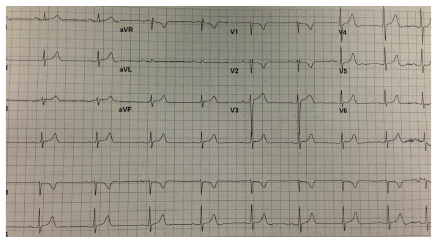
Figure 5: EKG showing sinus rhythm with rate of 56 bpm and PR interval of 180